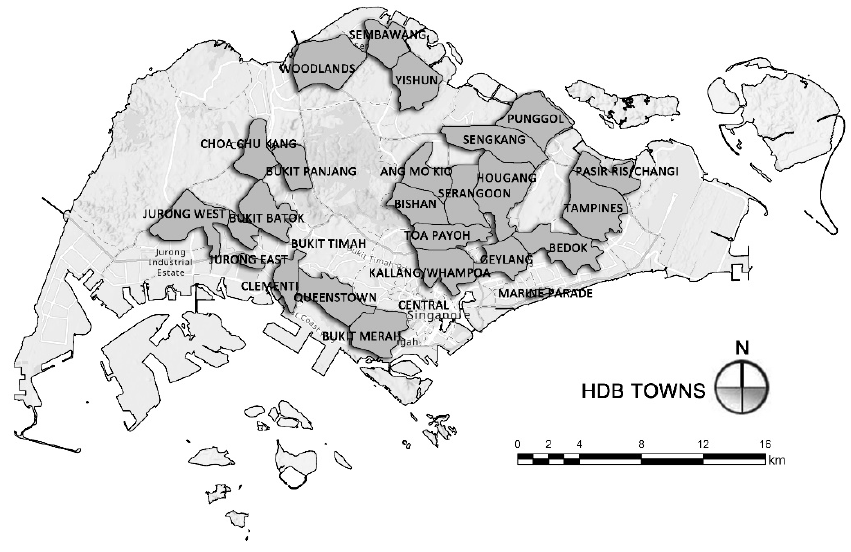
Figure 1. Locations of the HDB towns in Singapore.